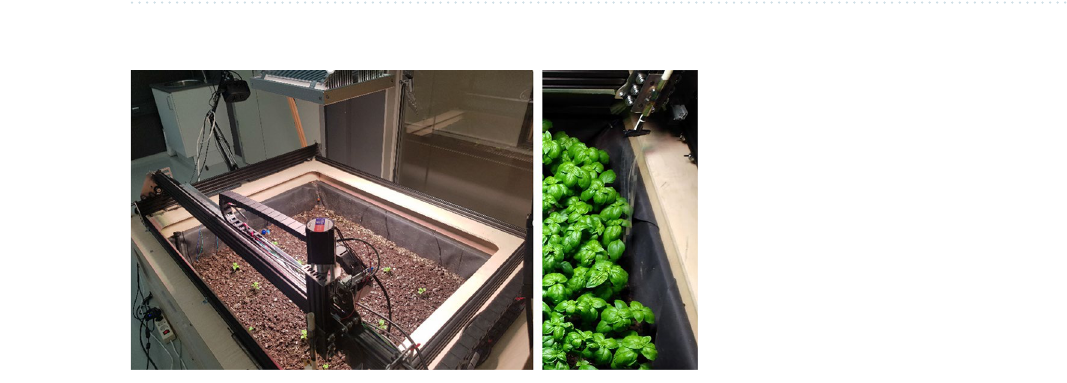
Figure 1. Seven-DoF robotic arm equipped with a stroking end-effector, placed in a commercial-type basil greenhouse setting.